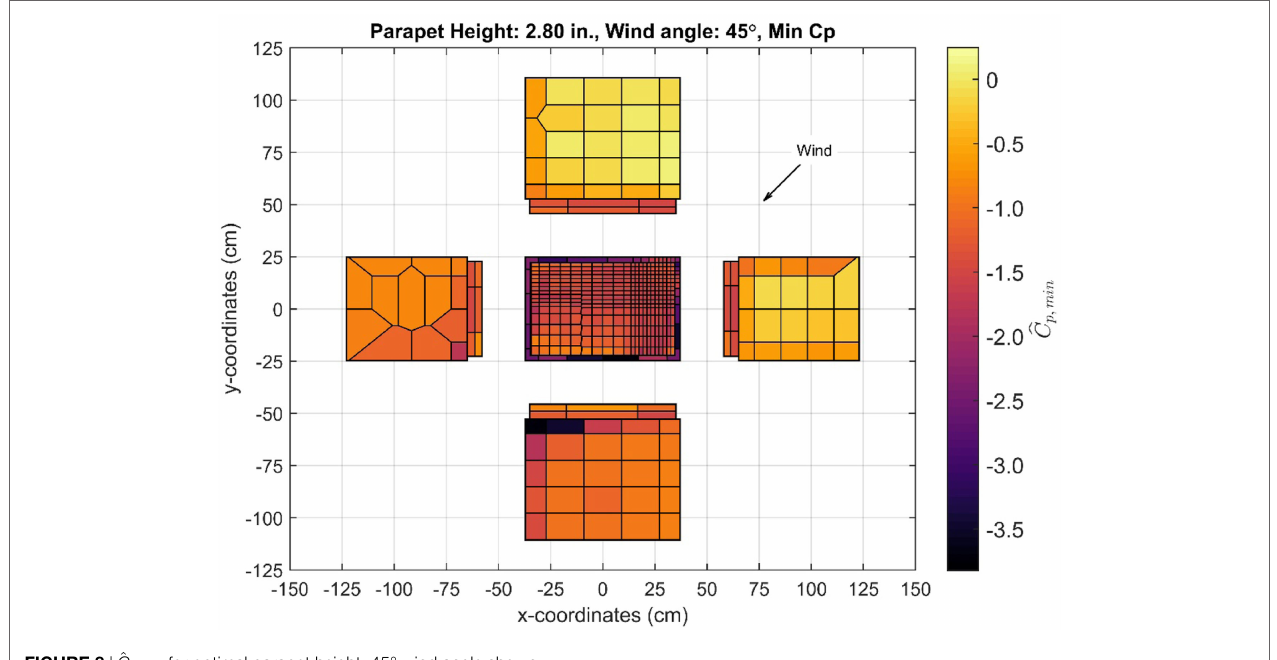
FIGURE 8 | ^ C p ; min for optimal parapet height, 45° wind angle shown.